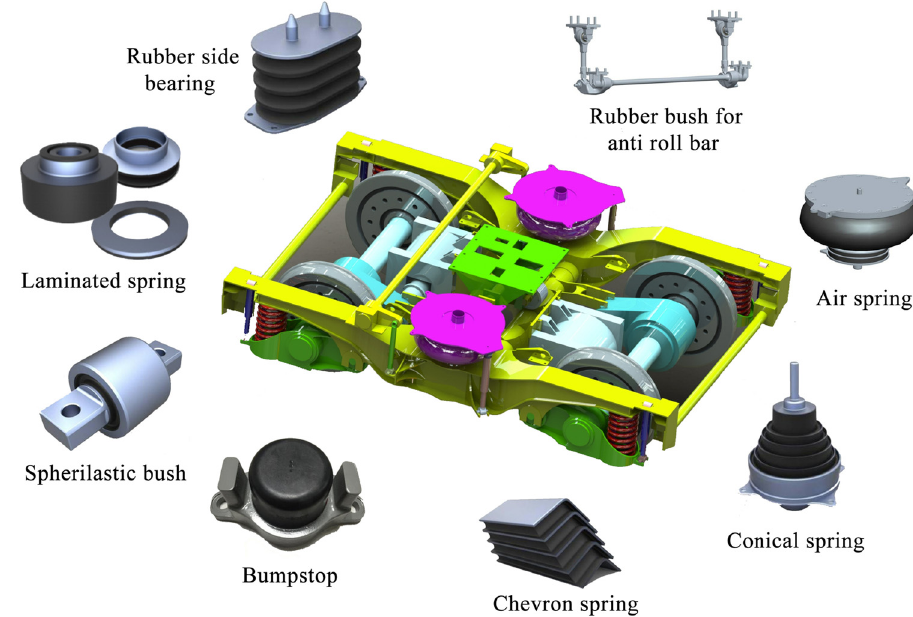
Figure 1: Rubber components in railway